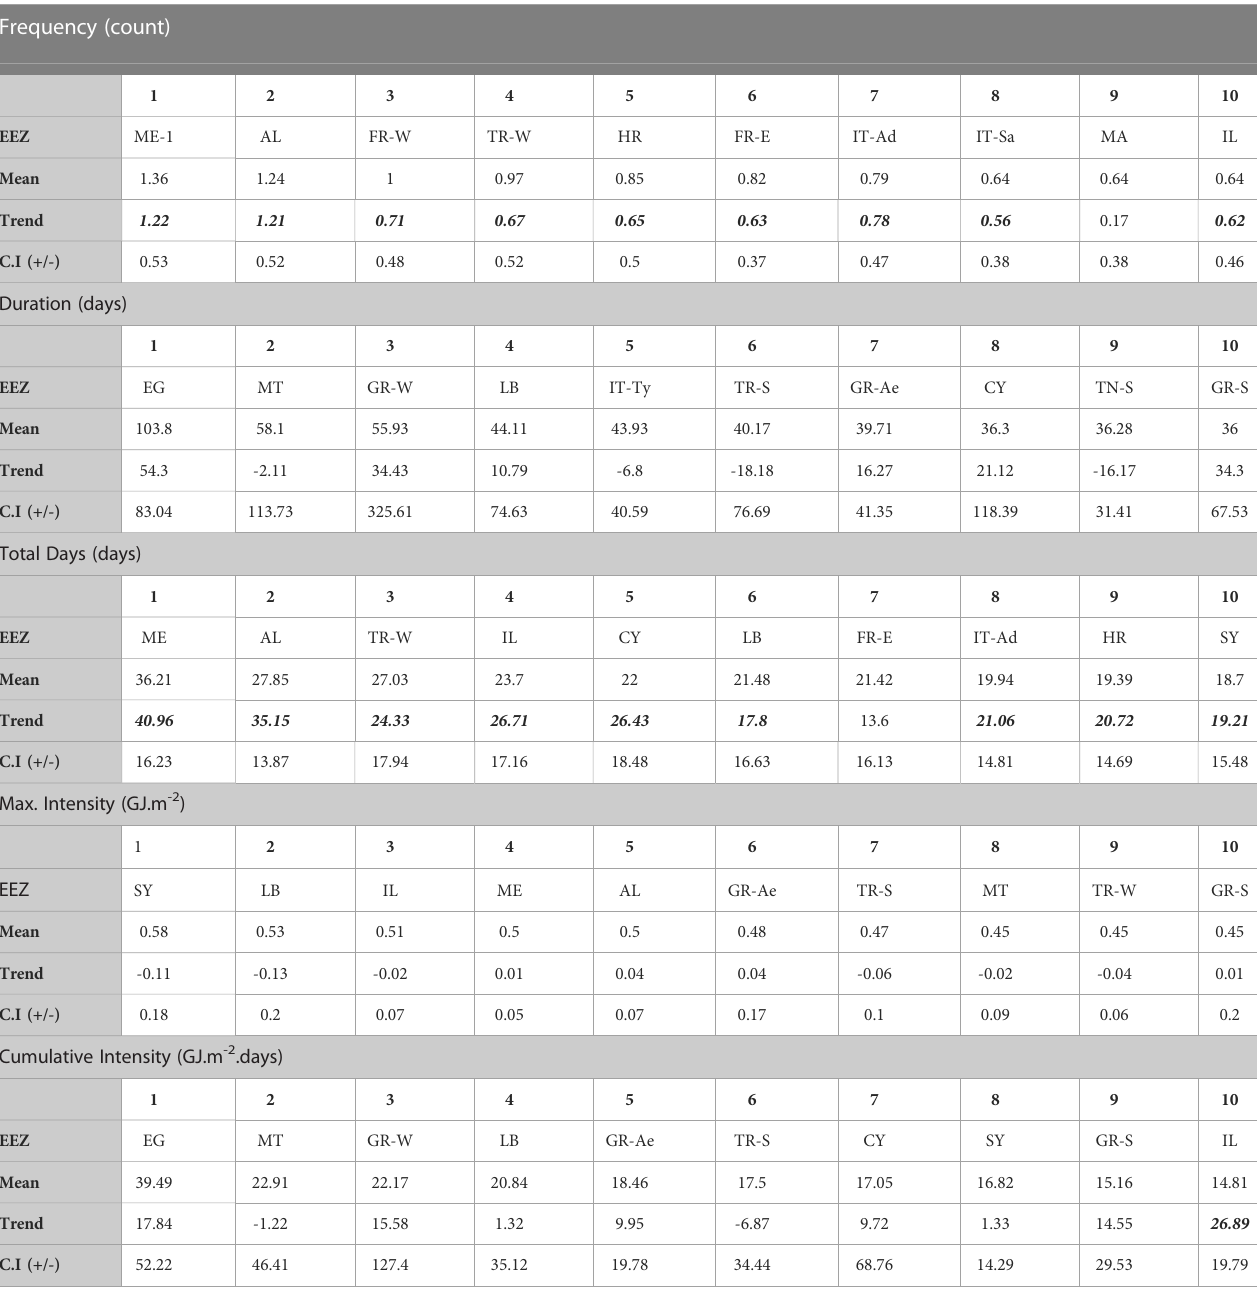
TABLE 3 Mean and trend for subsurface (OHC 0-100 m) MHW characteristics in EEZ areas (as displayed in Figure 1 ). Frequency